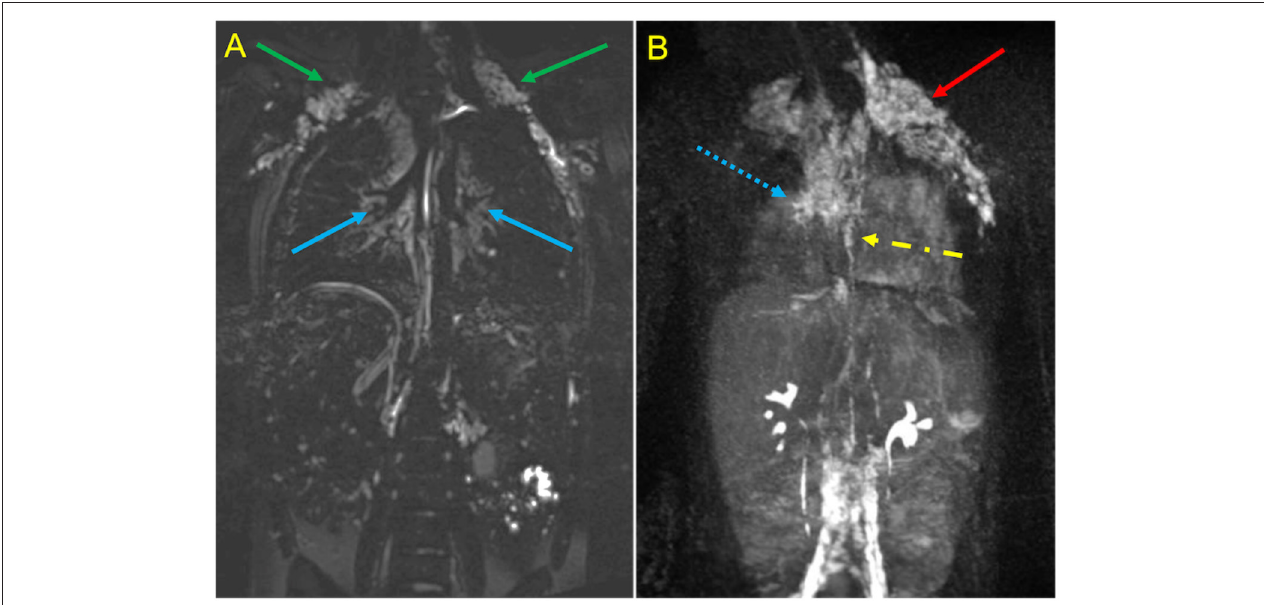
FIGURE 5 | MR Lymphangiography in a Patient treated with TCPC palliation complicated by plastic bronchitis. Static T2-SPACE coronal image (A) demonstrates abnormal supraclavicular (green arrows) and peri-hilar (blue arrows) lymphostasis. Dynamic contrast-enhanced MIP coronal image (B) after intranodal contrast injection shows rapid filling of retroperitoneal lymphatics and of the thoracic duct (yellow arrow), with marked reflow into supraclavicular (red arrow) and mediastinal channels (dotted blue arrow).